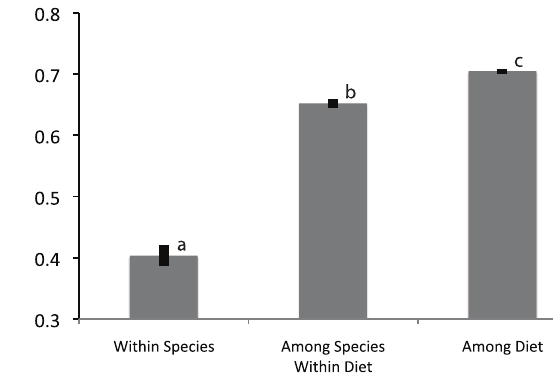
Table 3. Analysis of Similarity of bacterial communities across insect